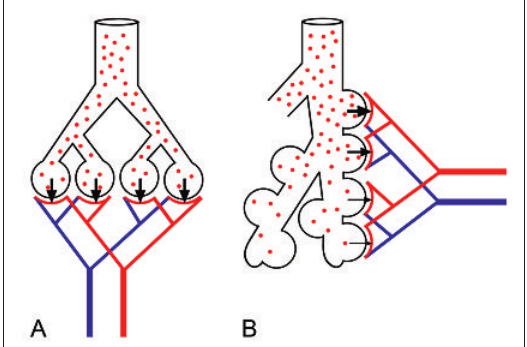
Models of ventilation-perfusion relationship in the mam- malian pulmonary gas exchanger. A . Parallel ventilation/ parallel perfusion. B . Serial ventilation/parallel perfusion. [ From 47